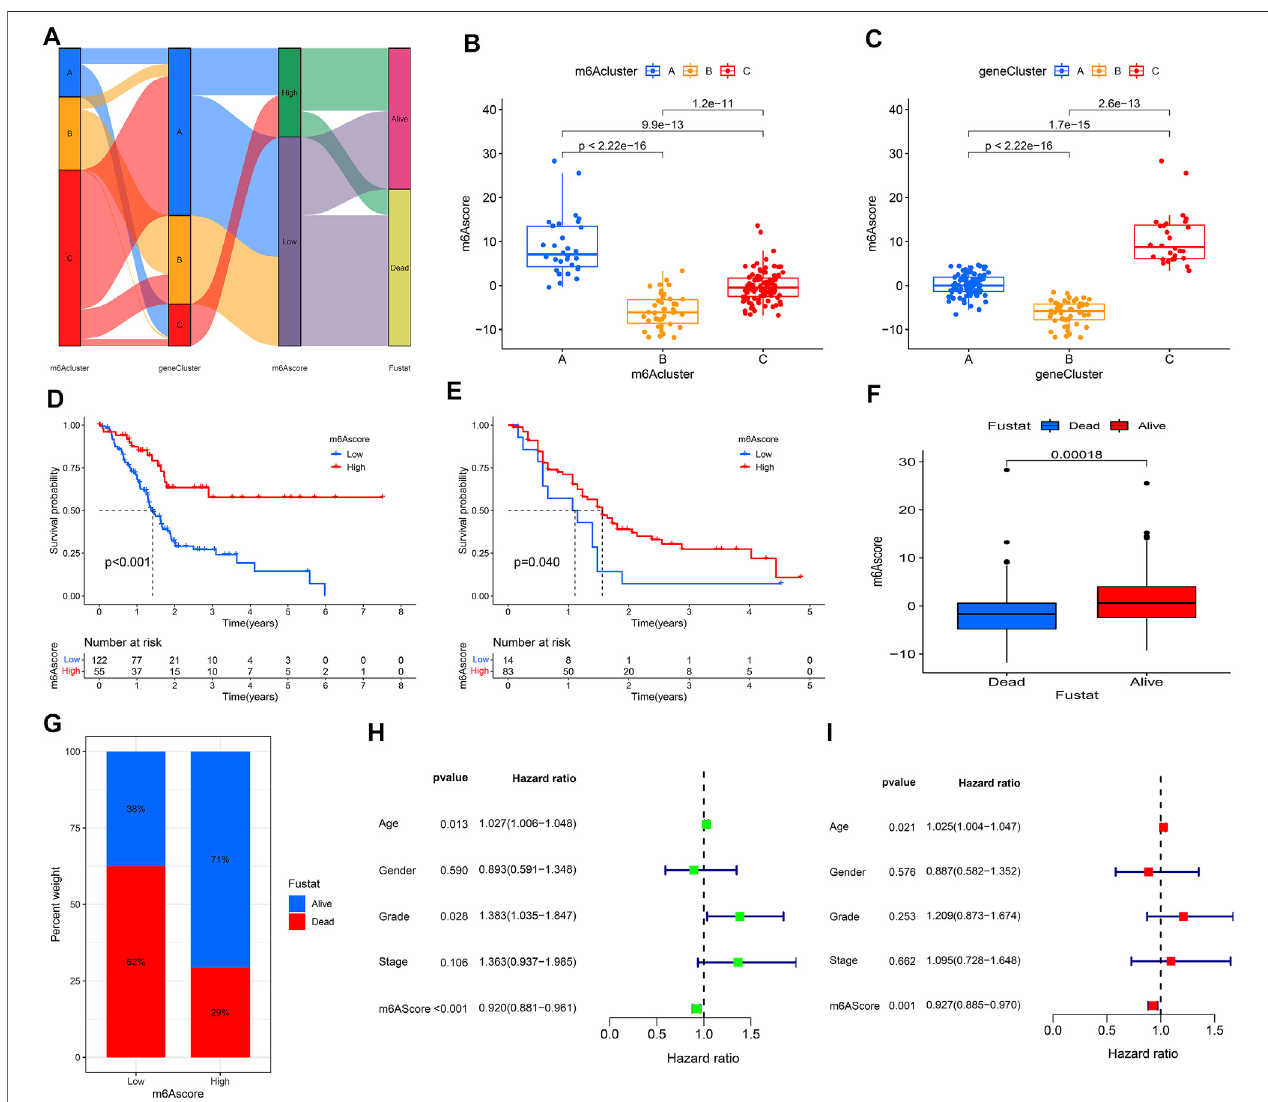
FIGURE7| Constructionofm6Ascoremodel. (A) Alluvialdiagramshowedthechangesofm6Aclusters,geneclusters,andm6Ascore; (B) Differencesinm6Ascore betweenthreem6Aclusters; (C) Differencesinm6Ascorebetweenthreegeneclusters; (D) KManalysisofpatientsinthehigh-andlow-m6Ascoregroups(TCGAcohort); (E) KM analysis of patients in the high- and low-m6Ascore groups (GEO cohort); (F,G) Clinical correlation analysis; (H) Univariate independent prognostic analysis; (I) Multivariate independent prognostic analysis.